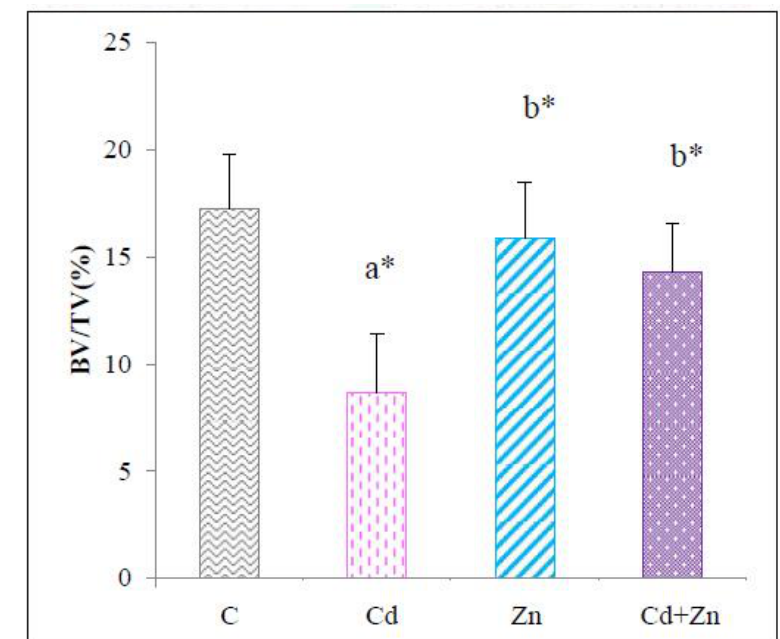
Figure 7. Histological section ( a ) of distal femur of rat pups (PND21) from control females and pups from females exposed to cadmium (50 mg/L Cd as CdCl2) and/or zinc (60 mg/L Zn as ZnCl2) during gestation and lactation (scale bar: 400 μm). Bone mineral volume (%BV/TV) was evaluated by counting trabecular bone on the region of interest ( b ). Means ± SEM from six samples in each groups; a* ( p < 0.0001): significant difference compared to the control group (C); b* ( p < 0.01): significant difference compared to the Cd group (Cd).